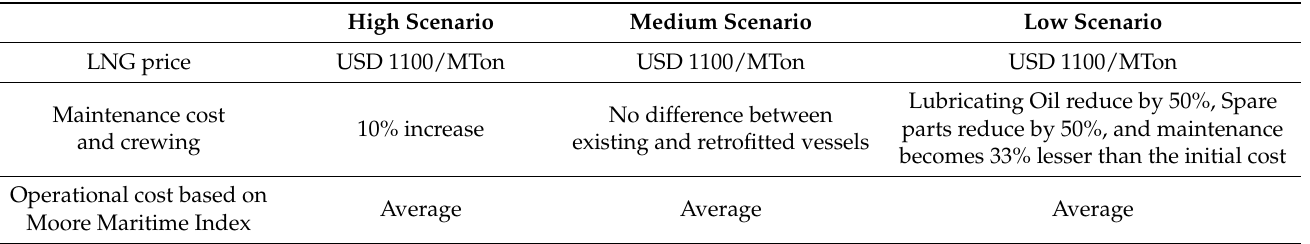
Table 1. Maintenance and crew cost